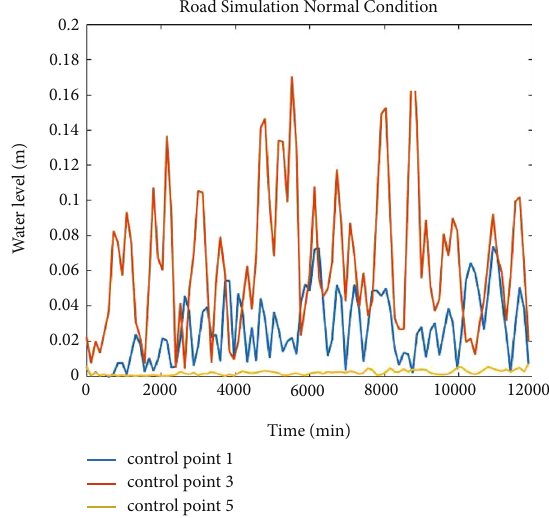
Figure 12: Fluctuation of the free-surface at the control point 1, 3, and 5 with road simulation normal